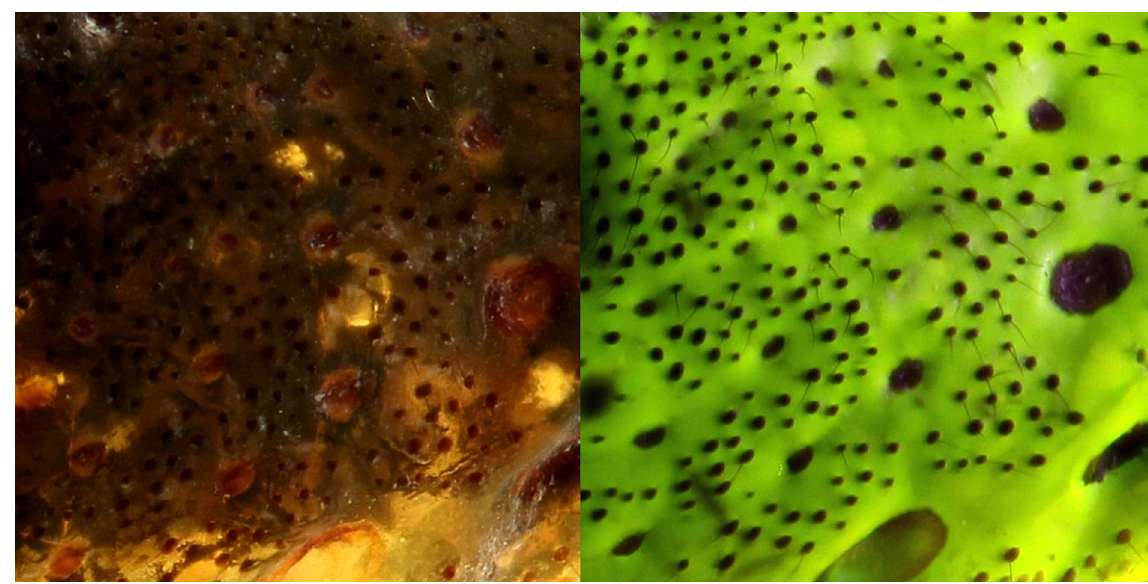
Fig. 4.2. Detail of a spider in white light on the left and in fluorescence on the right. Focus stacking